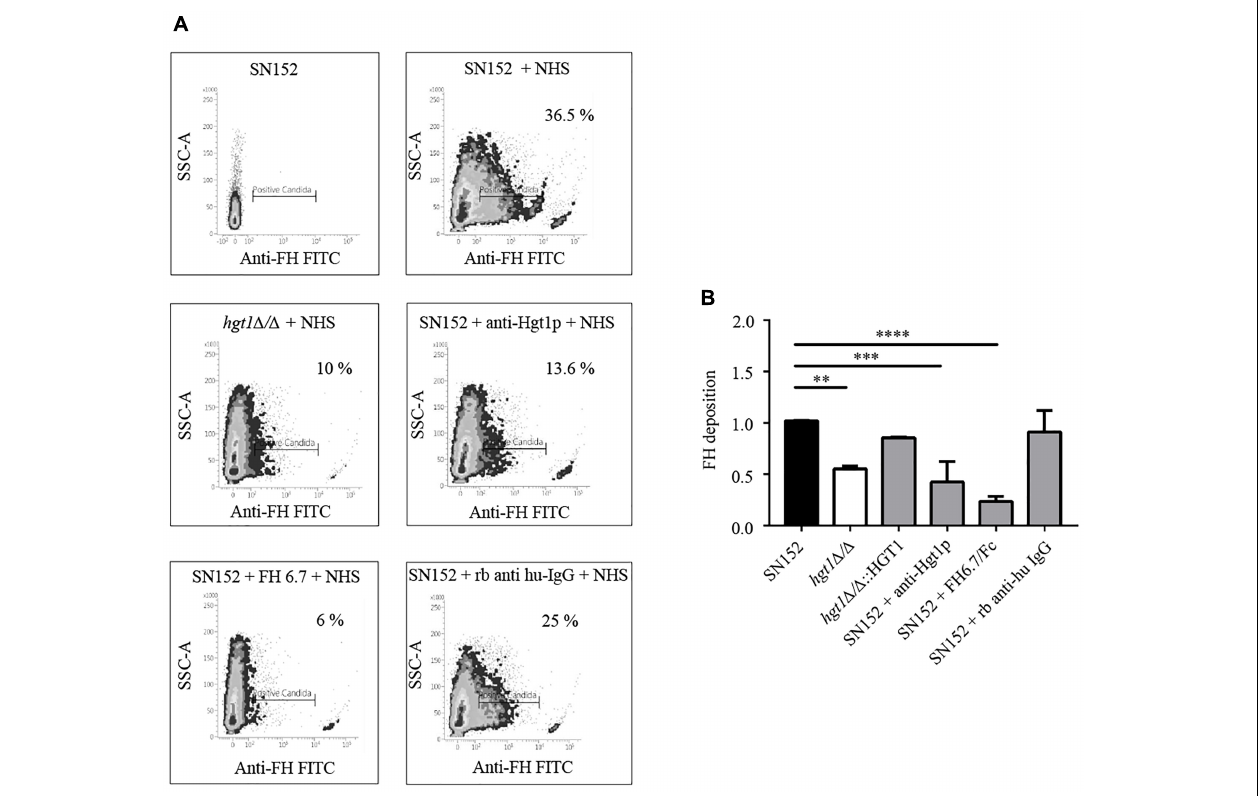
FIGURE 4 | Factor H (FH) binding to C. albicans . (A) Binding of FH present in NHS to C. albicans was analyzed by FACS. Density plots from one representative experiment are shown. X-axis, fluorescence of FH binding. Gates represent the % of C. albicans cells that stain positively for FH. Y-axis, side scatter (SSC). The components of the reaction mixture are indicated above each graph. (B) Cumulative data of FH binding to C. albicans . FH binding to SN152, hgt1 (cid:49) / (cid:49) , hgt1p (cid:49) / (cid:49) ::HGT1 reintegrated strain, or SN152 pre-incubated with anti-Hgt1p or the chimeric molecule FH6.7/Fc, or with irrelevant rabbit anti-human IgG. Data are expressed as mean fluorescent intensity (MFI) normalized to SN152 parental strain. Bars represent the normalized mean fold-increase + SD of five separate experiments ∗∗ p < 0.01, ∗∗∗ p < 0.001, ∗∗∗∗ p < 0.0001, by one-way ANOVA, using SN152 for